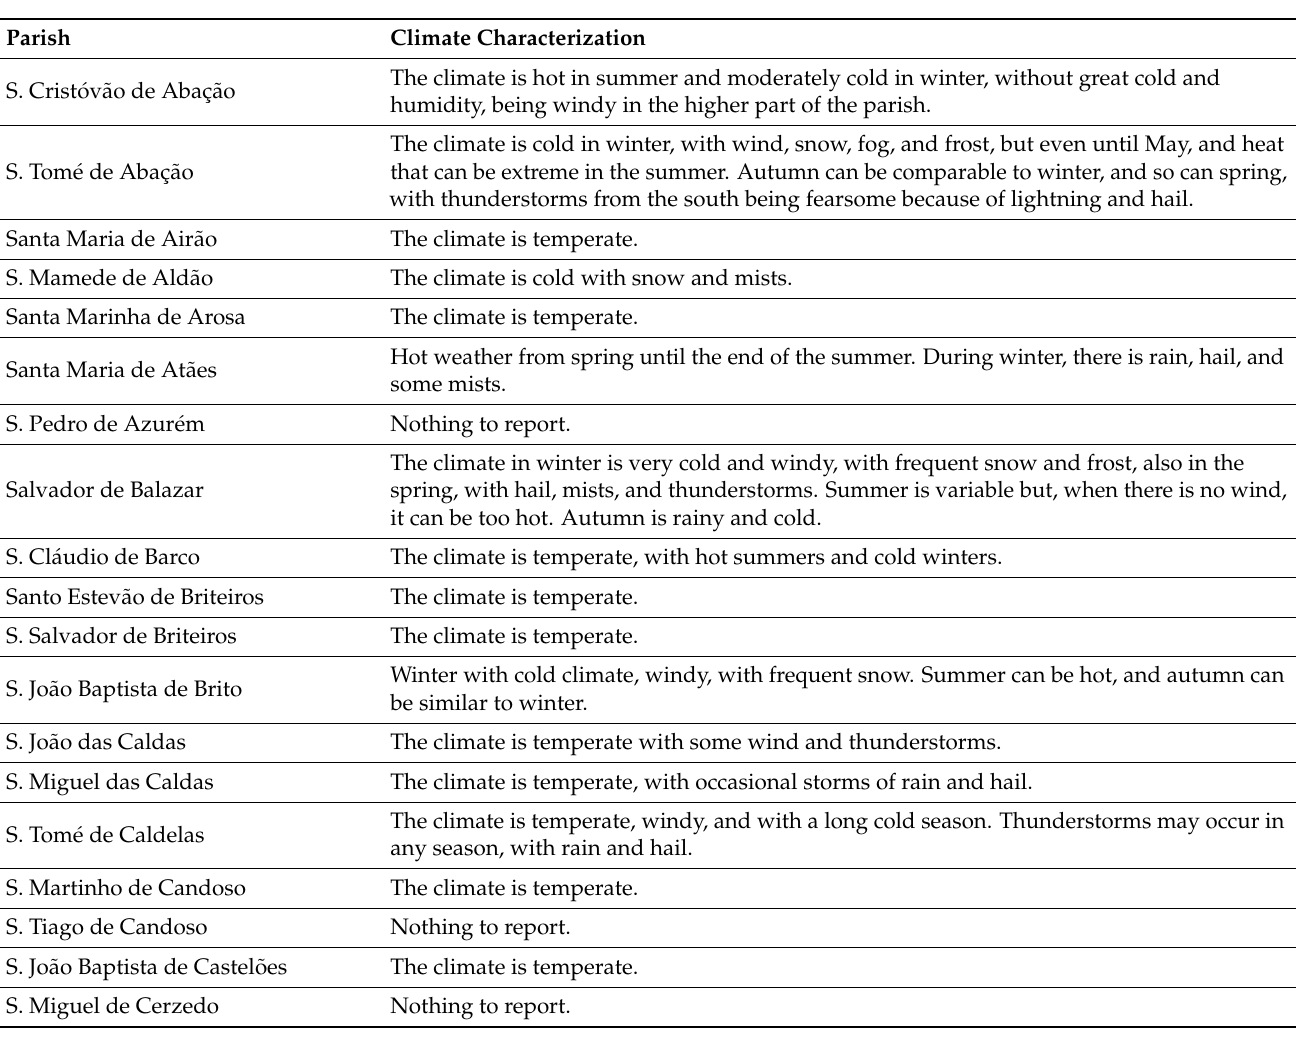
Table 5. Results of the survey conducted by the Municipality of Guimar ã es in